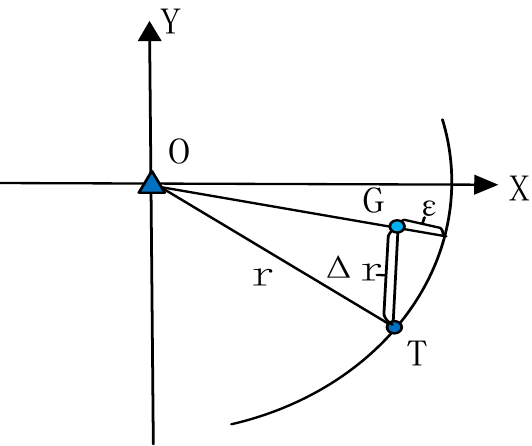
Figure 4. The ranging error caused by the approximate position error.